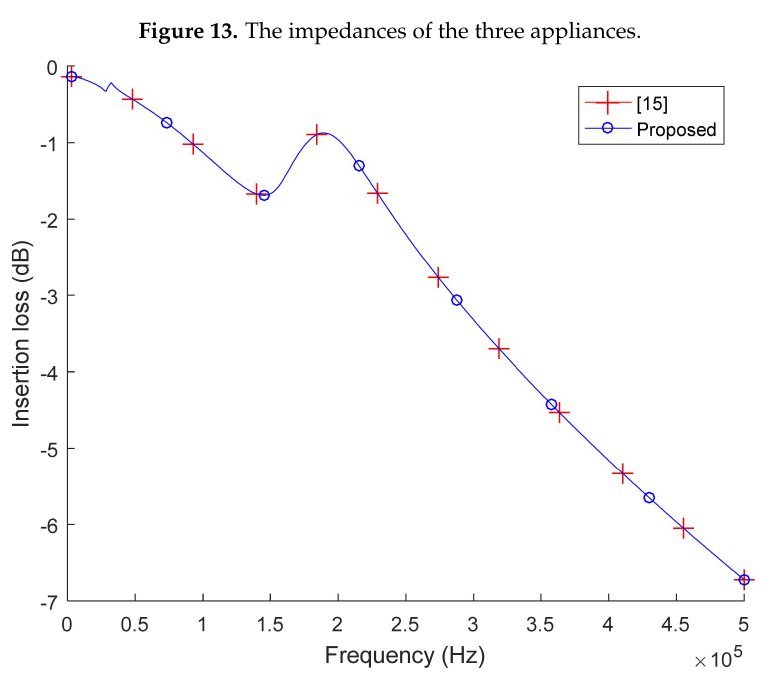
Figure 14. The TFs of the Cañete wiring topology using two